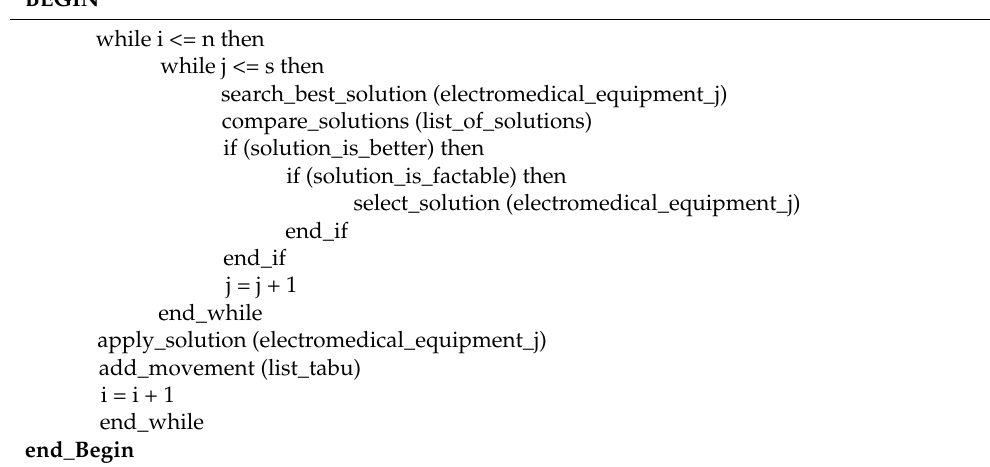
Table 1. Tabu search algorithm